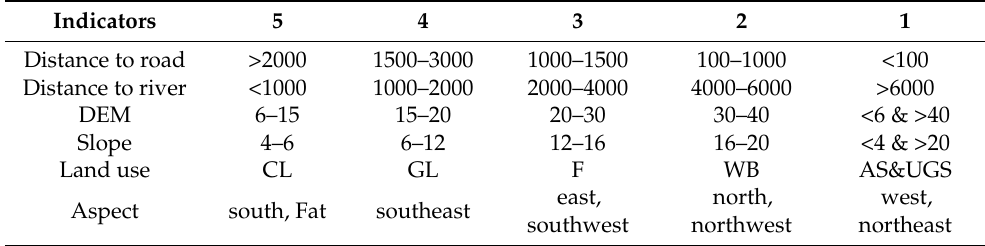
Table 3. Grading of the suitability evaluation indicators for cropland.